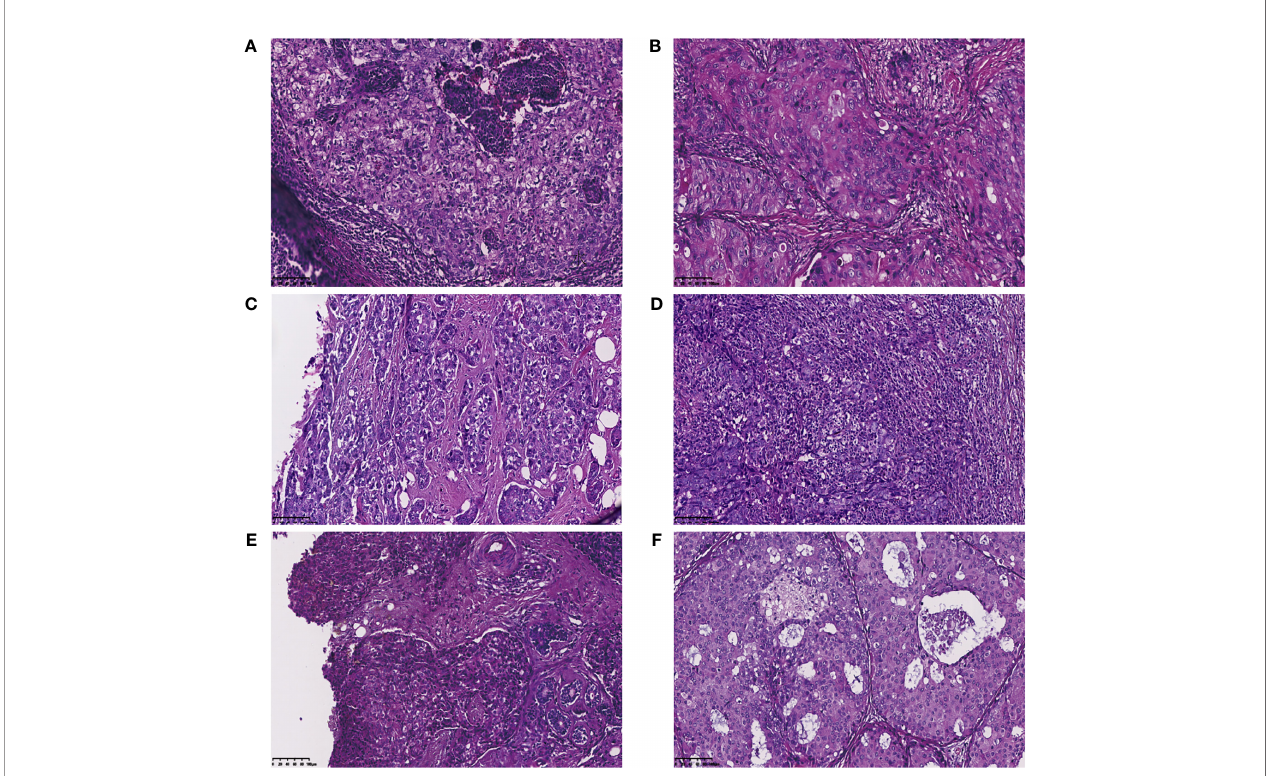
FIGURE 1 | Invasive ductal carcinoma of no-special type and special morphologic pattern of triple negative breast cancers. (A) Invasive ductal carcinoma; (B) Apocrine carcinoma (Carcinoma with apocrine differentiation); (C) Metaplastic breast carcinoma; (D) Medullary carcinoma; (E) Glycogen-rich clear cell carcinoma; (F) Mixed